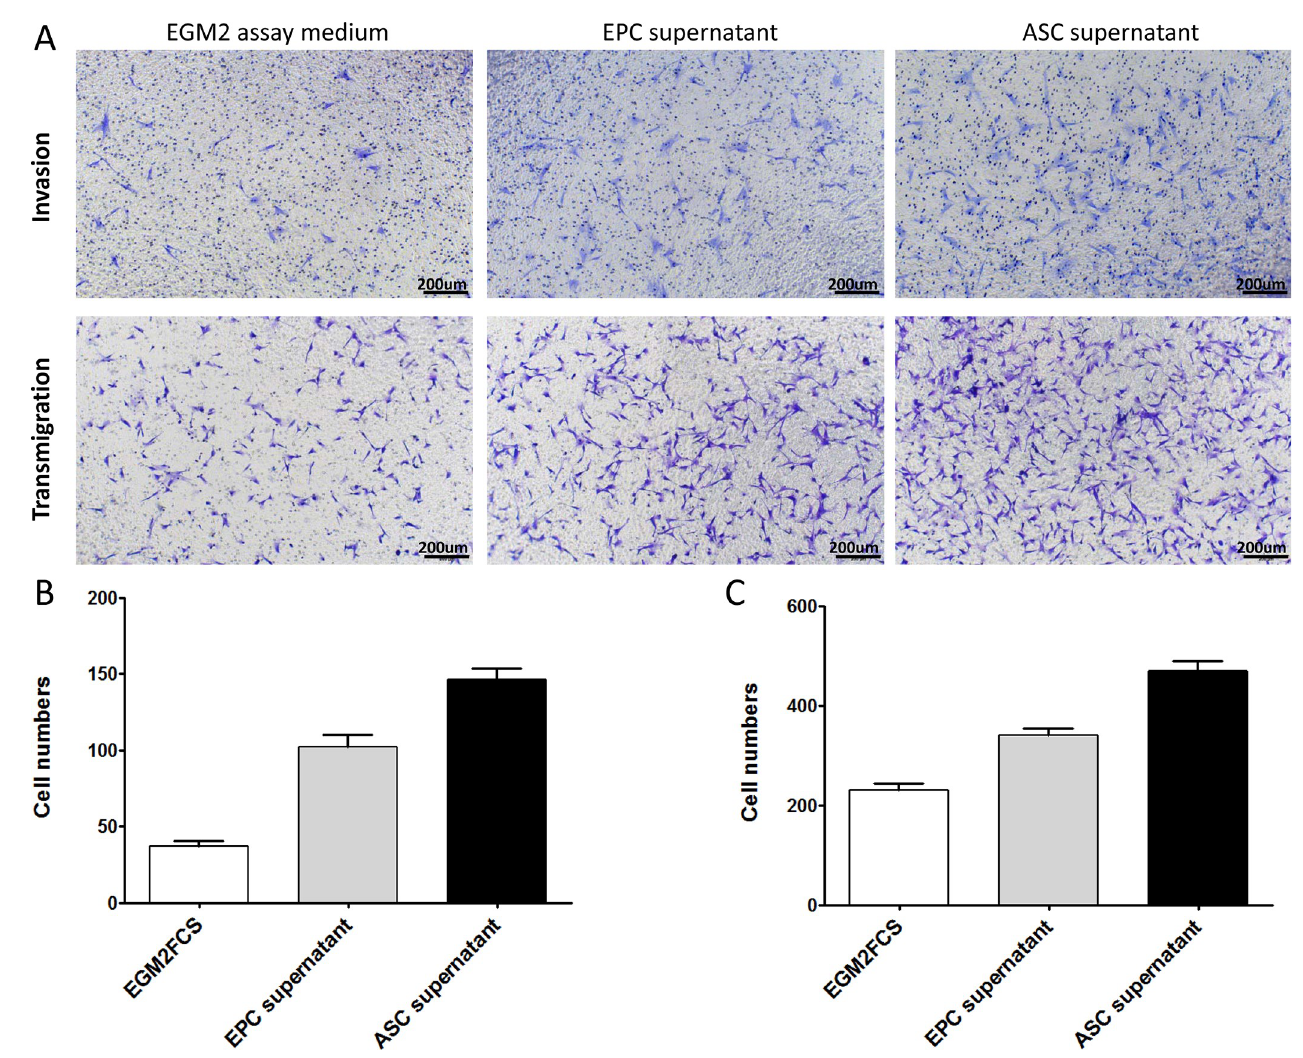
Fig 5. Supernatant from ASCs cultures promotes EPCs invasion and migration in vitro . (A)Representative images of EPCs invasion and migration in the presence of EPCs supernatant, ASCs supernatant, or fresh EGM2 assay medium, respectively. Quantitative analysis of EPC invasion (B) and migration (C). Data are expressed as mean ± SEM. � , P <